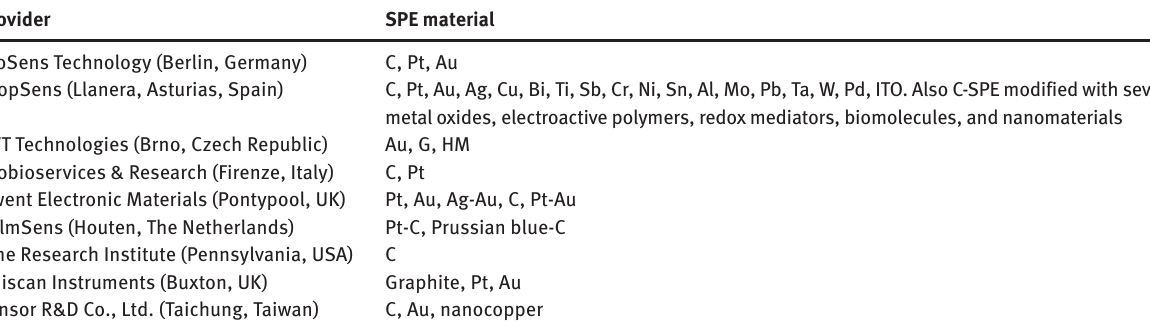
Table 1: Examples of providers of SPE and types of SPE produced by each of them.